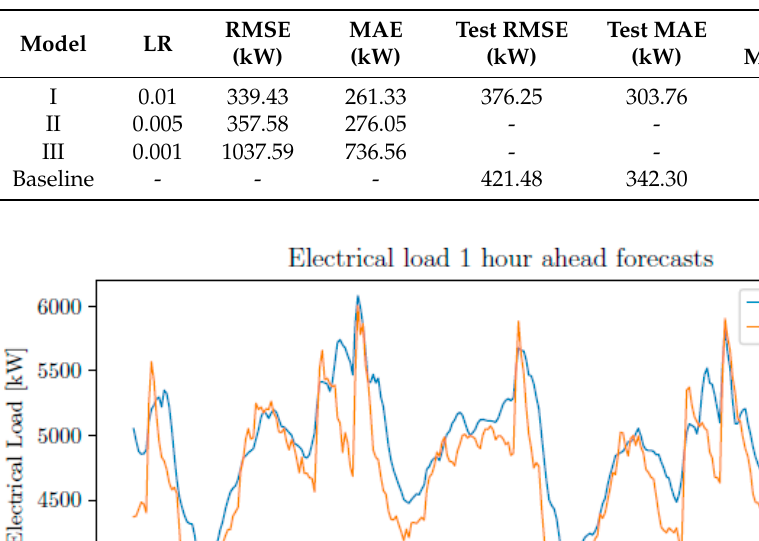
Table 4. Results of the 1-h-ahead initial and baseline models.